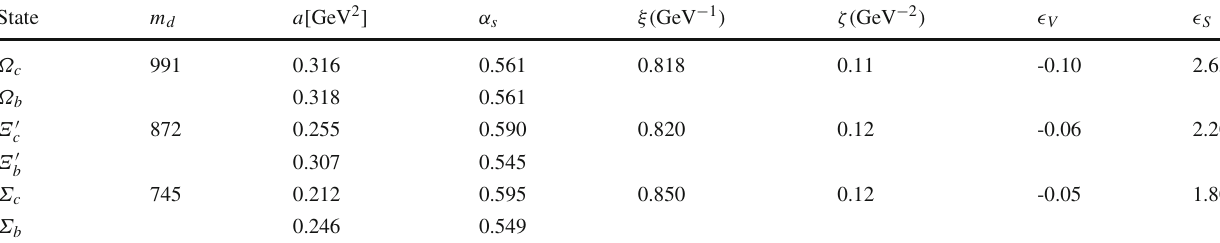
Table 9 Inputs for the model parameters and diquark masses defined in Hamiltonian (C1) (Appendix C) for the P-wave heavy baryons listed. The heavy quark masses m Q = M Q = 1440 MeV ( Q = c ) and